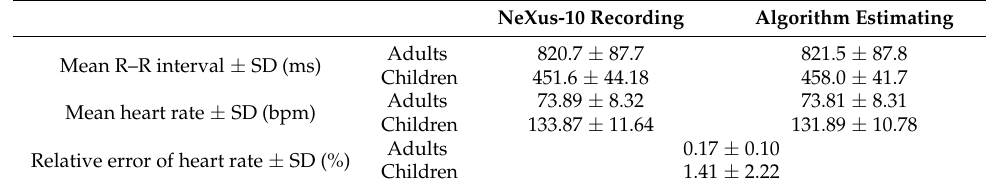
Table 2. R-Wave detection algorithm results (clinical patient).